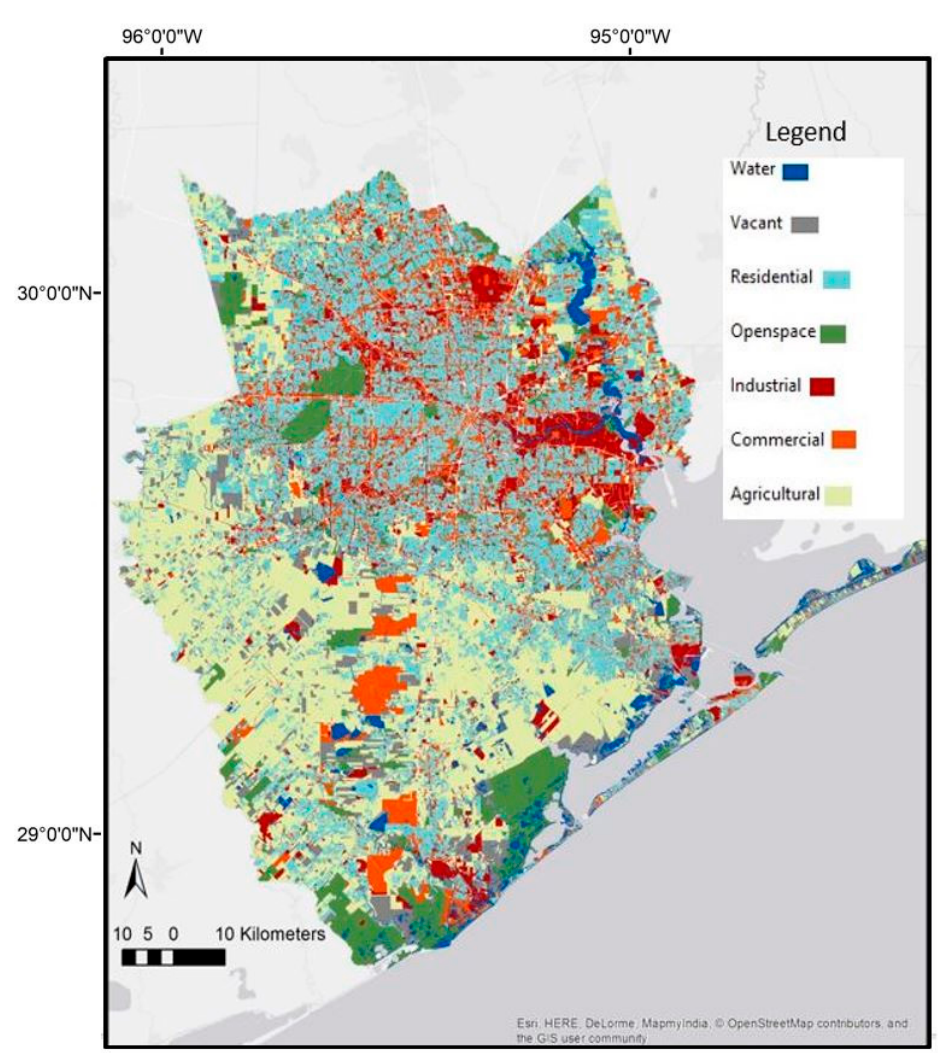
Figure 4. Houston-Galveston Area Council (H-GAC) Regrouped land use Figure 4 . Houston-Galveston Area Council (H-GAC) Regrouped land use patterns